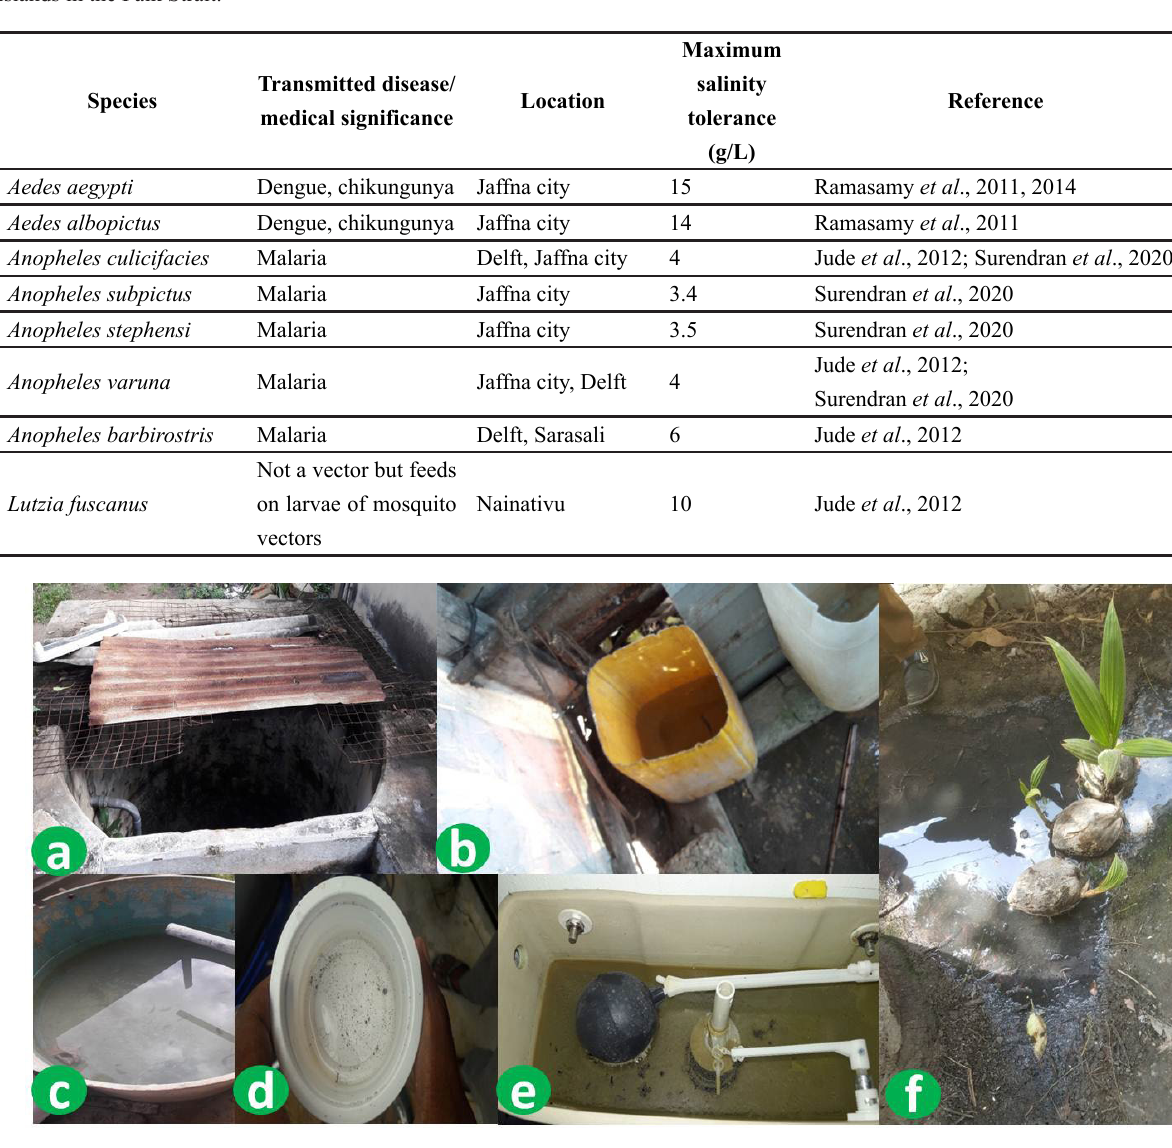
Table 3: Freshwater mosquito vectors of human diseases that have adapted to brackish water habitats in the Jaffna peninsula and islands in the Palk Strait.